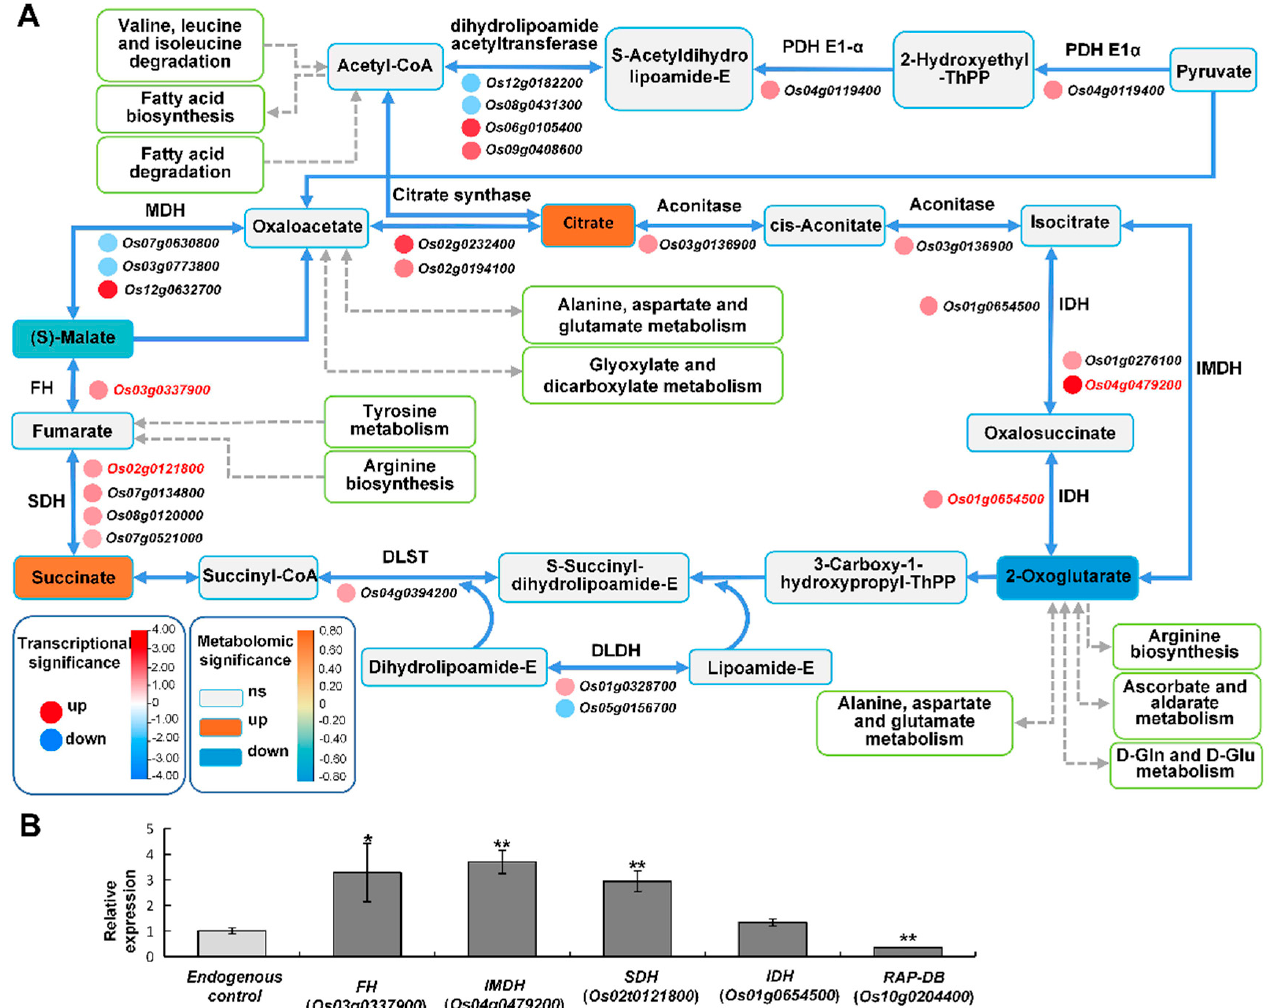
Figure 8. Overview of the TCA cycle in response to HSA stress. ( A ) The DEGs and related DAMs involved in TCA cycle. The meanings of rectangles, circles, colors, and lines are the same as those in Figure 7. The rectangles with the white color and green frame are other metabolic pathways linked to TCA cycle. ( B ) The gene expression levels validated using RT-qPCR. Data are presented from three independent experiments performed with three replicates per experiment. *, p < 0.05; **, p < 0.01; Student’s t-test. Abbreviations: fumarate hydratase (FH); dihydrolipoamide succinyltransferase (DLST); dihydrolipoamide dehydrogenase (DLDH); isocitrate dehydrogenase (IDH); isopropylmalate dehydrogenase (IMDH); malate dehydrogenase (MDH); pyruvate dehydrogenase (PDH); phosphoenolpyruvate carboxykinase (RAP-DB); succinate dehydrogenase (SDH).